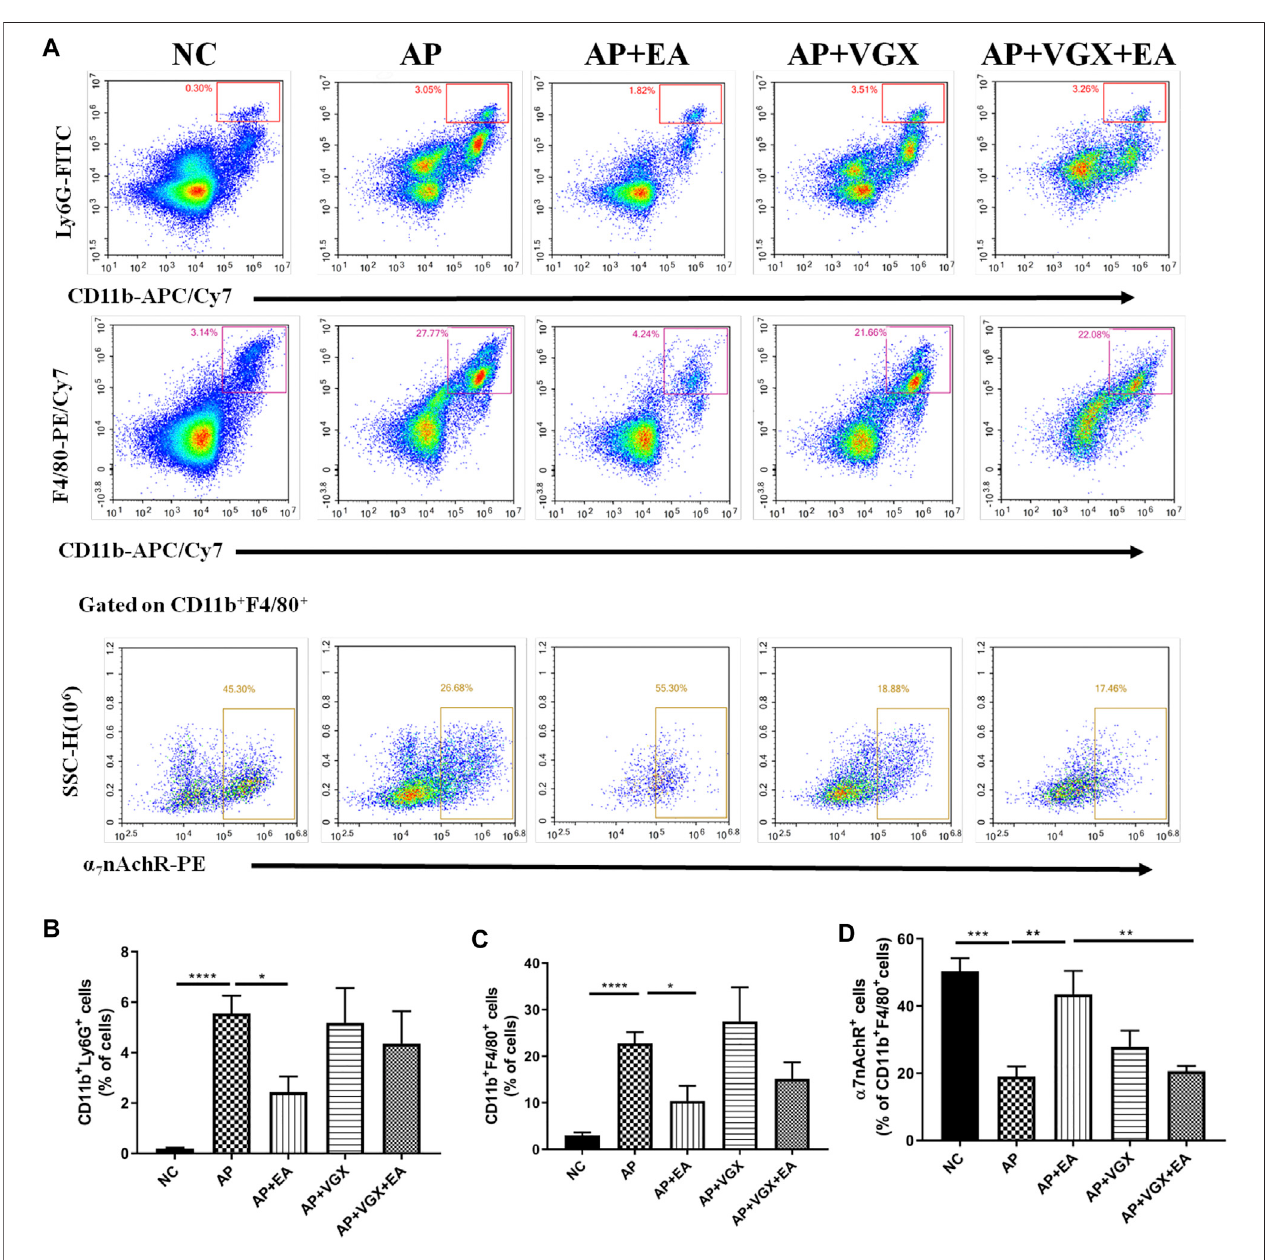
FIGURE4| EAdecreasesthein fi ltrationsofneutrophilsandmacrophagesandincreasesthefrequencyof α 7nAChR + macrophagesinthepancreasofcaeruleinAP mice. Pancreas-in fi ltrating leukocytes and acinar cells were isolated for fl ow cytometry (A) and percentages of CD11b + Ly6G + neutrophils (B) and CD11b + F4/80 + macrophages (C) were analyzed. The percentage of α 7nAChR-positive macrophages was also analyzed (D) , n (cid:1) 7 – 10. Bars show mean ± SEM. * p < 0.05, ** p < 0.01, *** p < 0.001, and **** p < 0.0001. NC, normal control; AP, acute pancreatitis; EA, electroacupuncture; VGX,